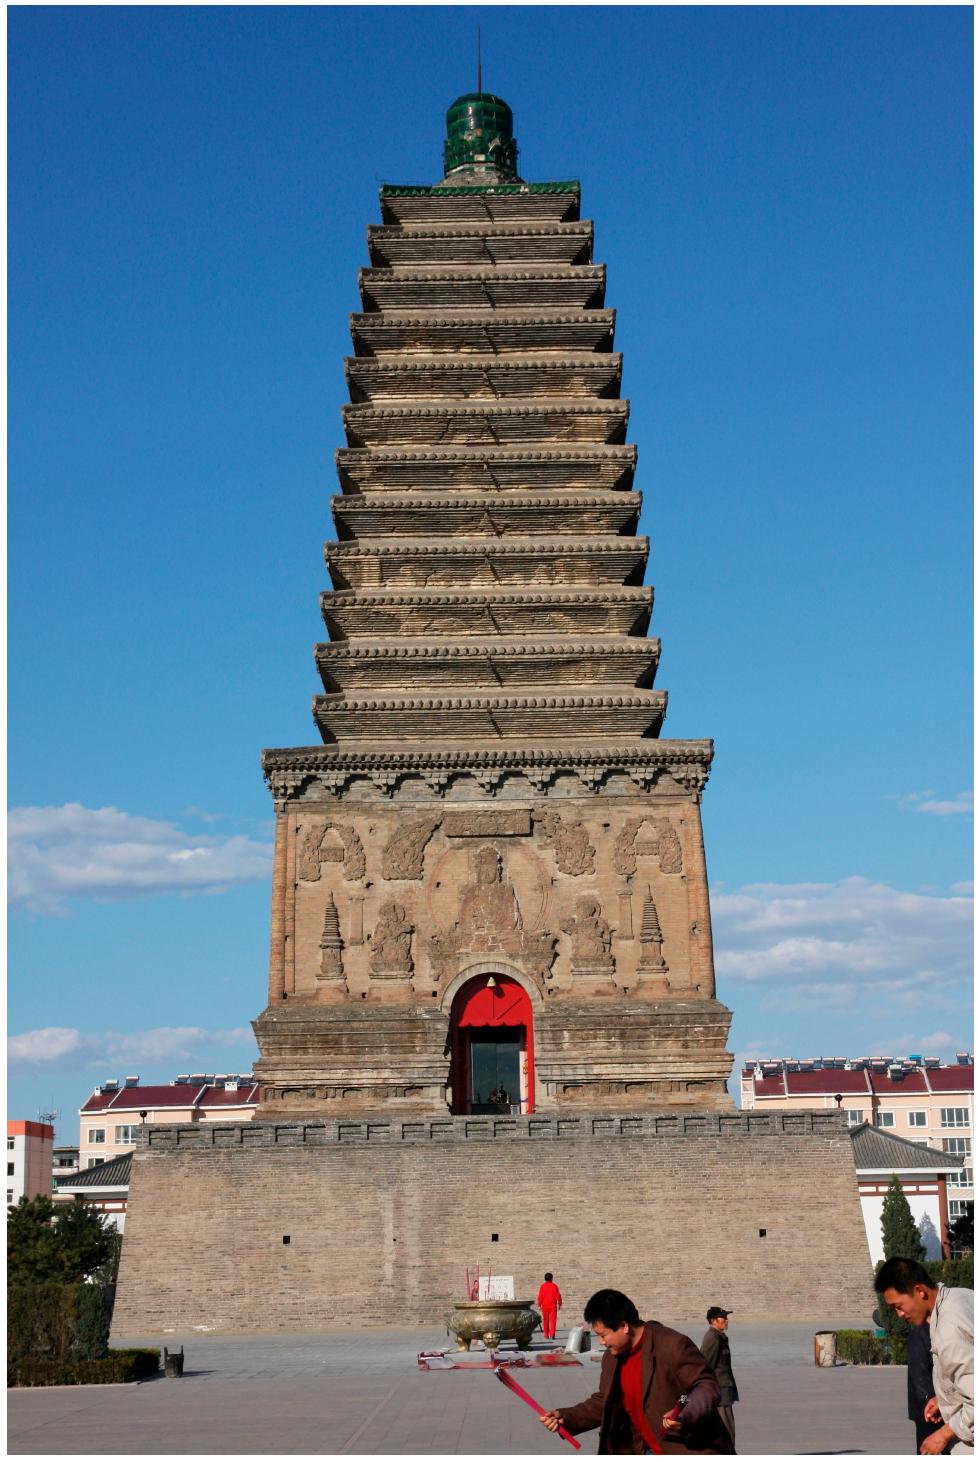
Figure 1. Chaoyang North Pagoda. Liao dynasty, 1043–1044. Chaoyang, Liaoning Province,